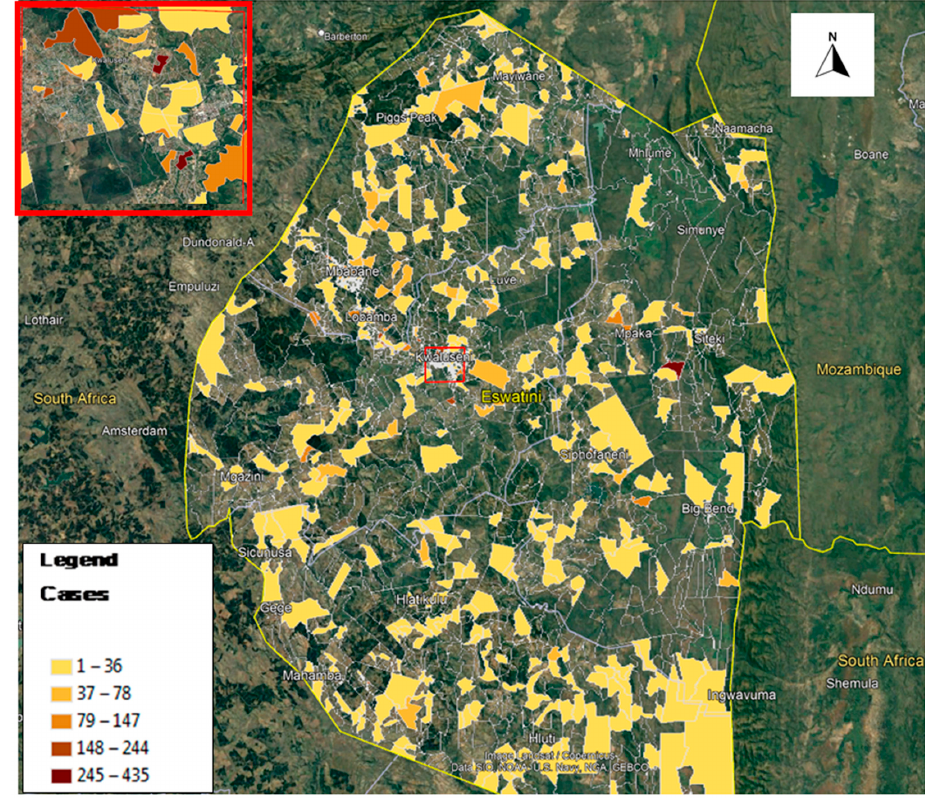
Figure 1. Distribution of reported COVID-19 cases in Eswatini. Table 1. Health, Demographic and Socio-Economic